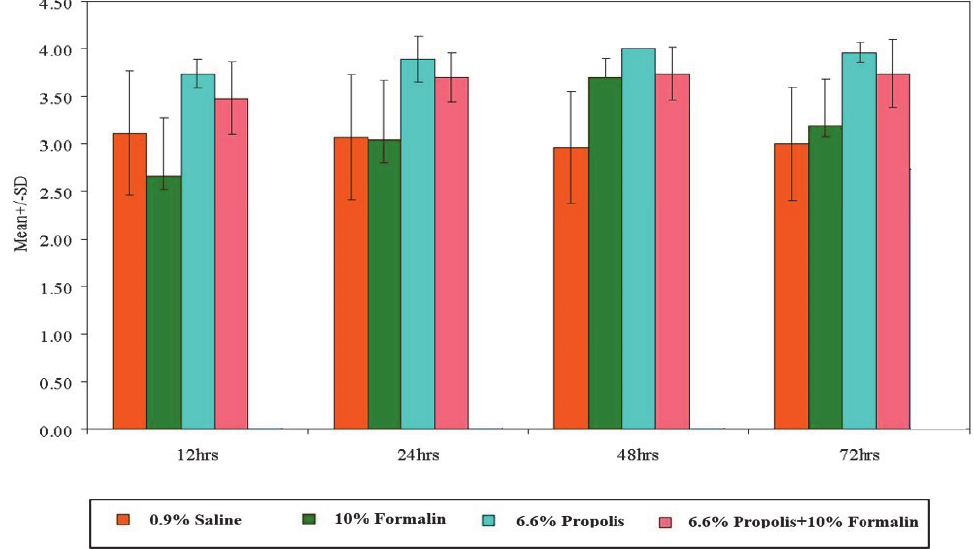
Figure 6. A graph showing between-group comparisons at different time points .